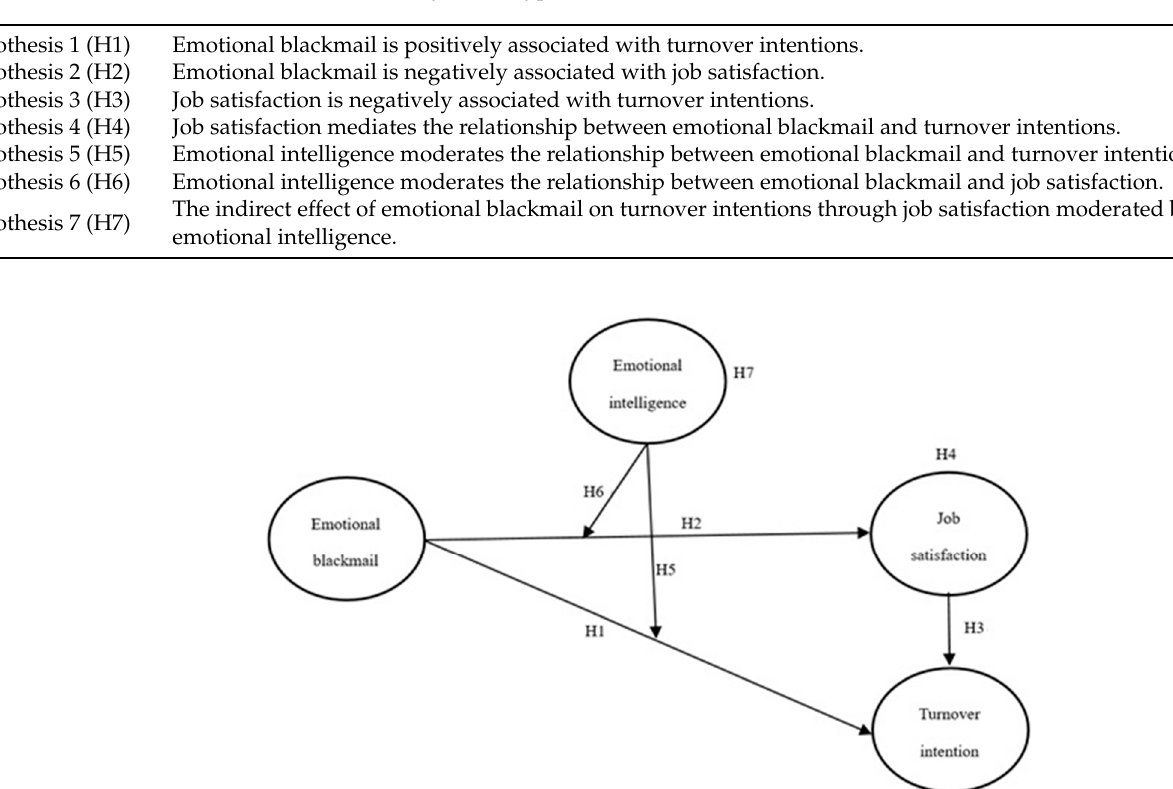
Table 1. Summary of the hypotheses.